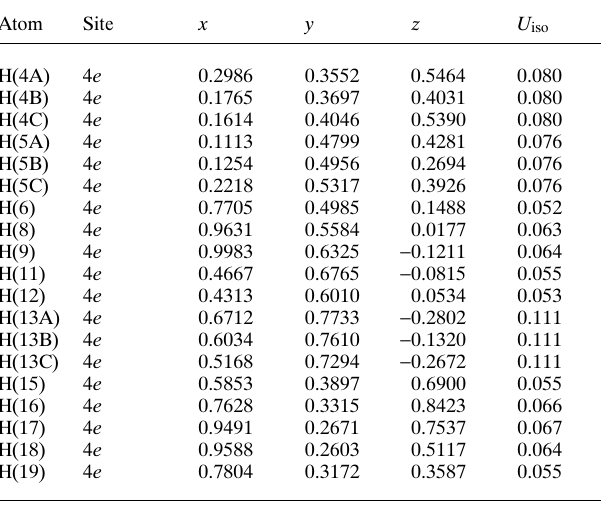
Table 2. Atomic coordinates and displacement parameters (in Å 2 ) . Atom Site x y